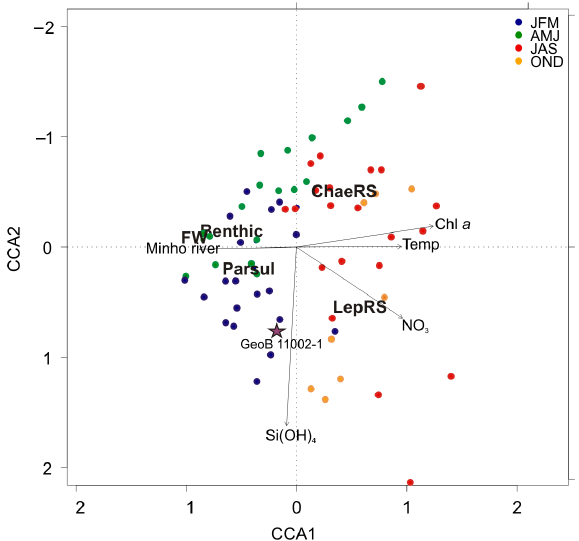
Figure 8. RDA biplot results of the canonical ordination (only significant variables shown) for main fossil sediment trap di- atom groups (freshwater (FW) diatoms, benthic diatoms, Par- alia sulcata (Parsul), Chaetoceros spp. spores (ChaeRS) and Lep- tocylindrus spp. spores (LepRS), and forward-selected environ- mental variables (chlorophyll a (Chl a) , temperature (Temp), ni- trates (NO 3 ) and silicates (Si(OH) 4 ) and Minho River flow). JFM: